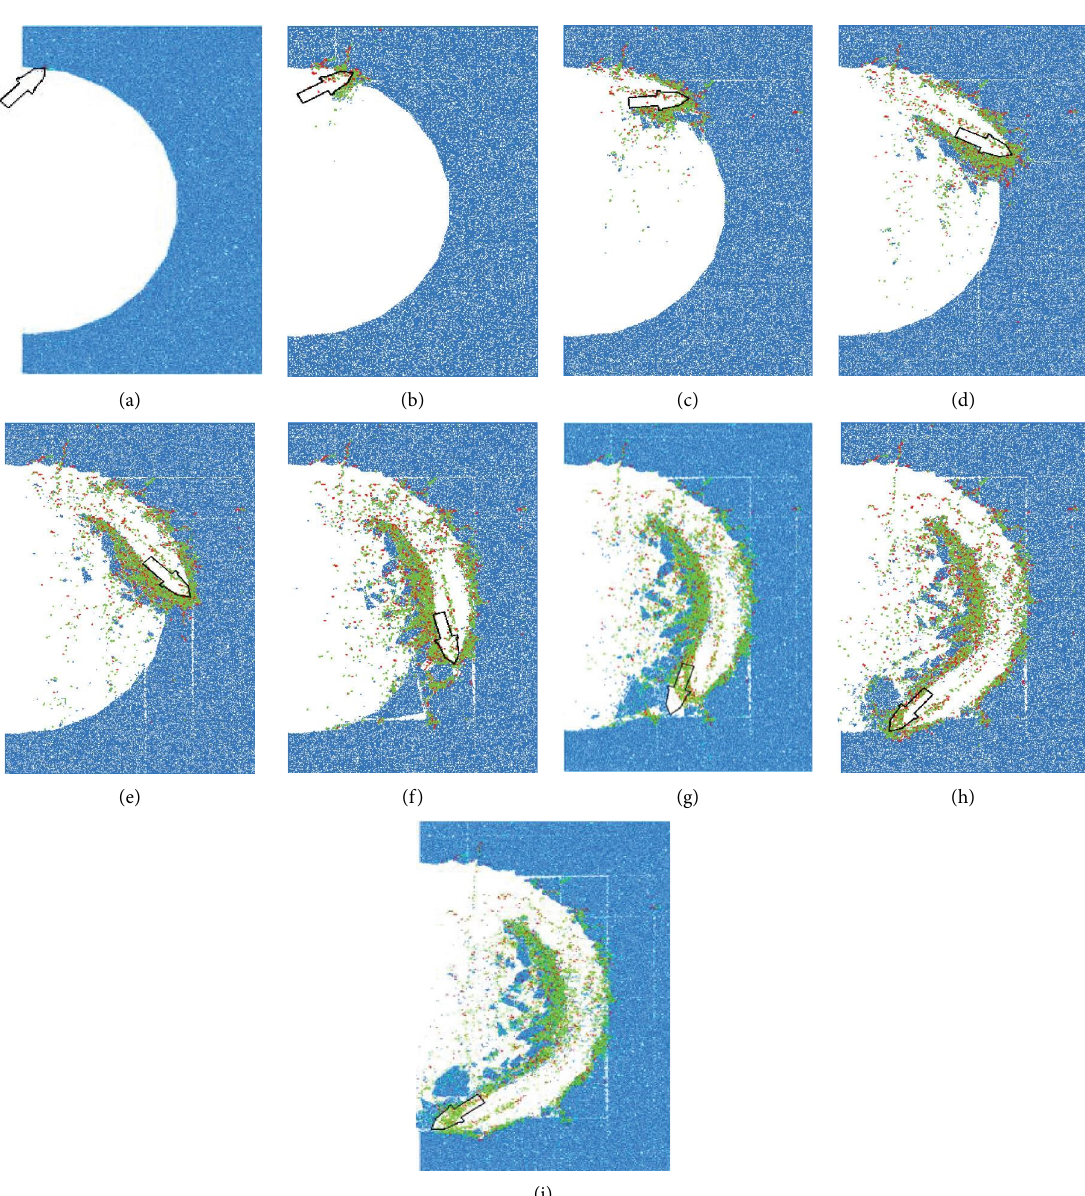
Figure 9: The dynamic cutting process of Figure